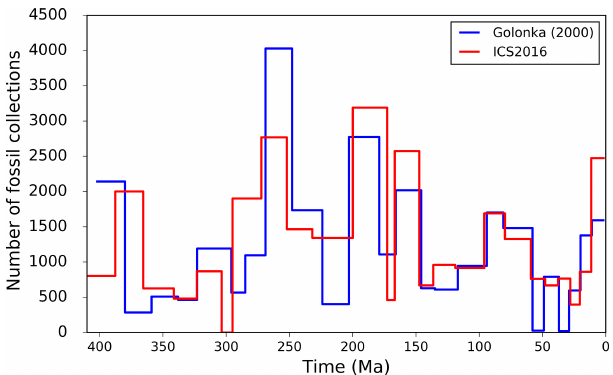
Figure 11. Fossil abundance test on the marine fossil collection data set used in this study with two different timescales: Golonka (2000) and ICS2016 (Table